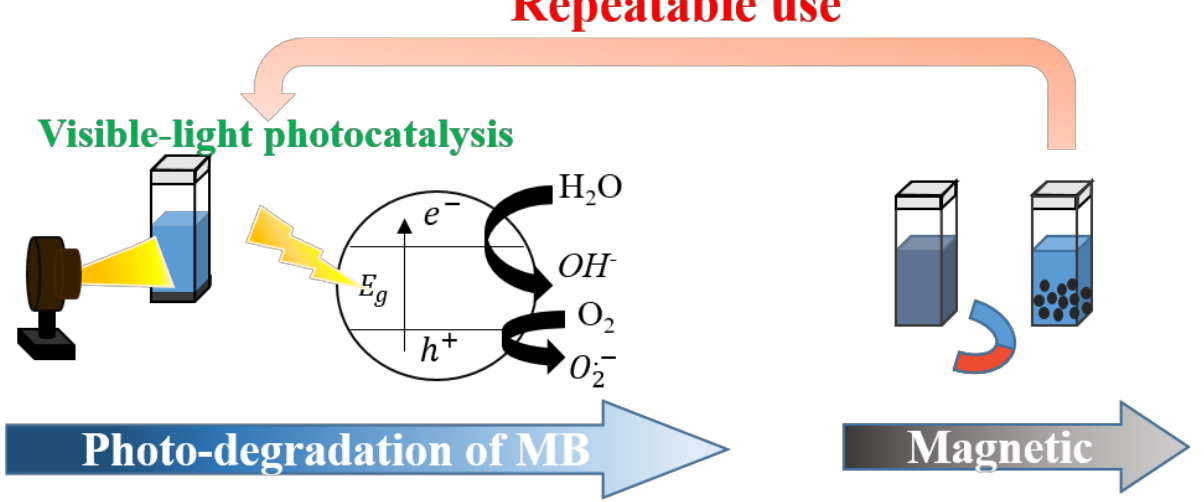
Figure 8. Schematic of possible reusability of magnetic NPs in visible-light photocatalysis.